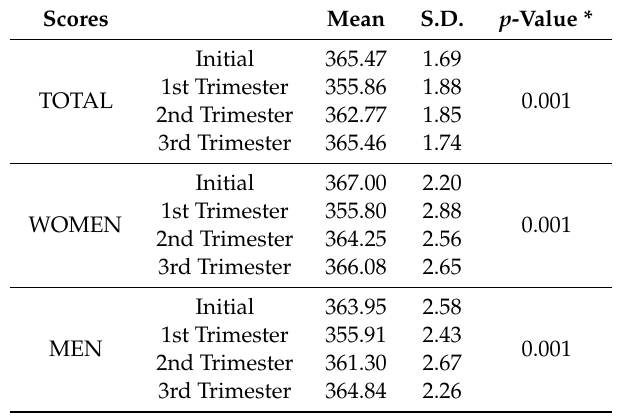
Table 5. Initial and final total scores of the means of each